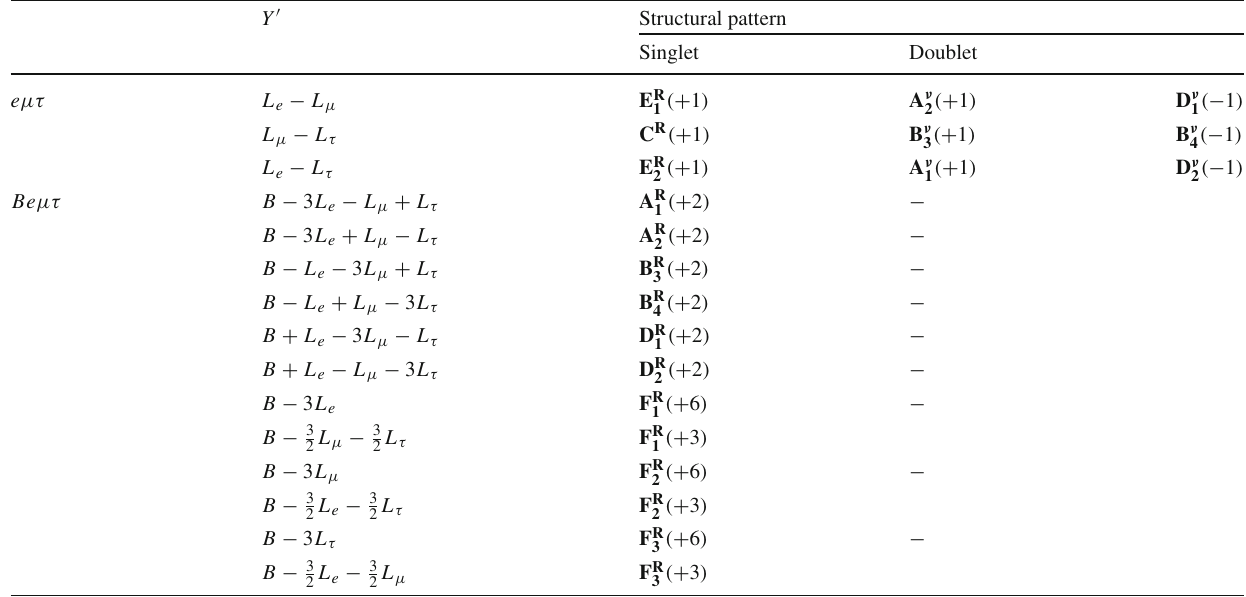
Table2 GaugedU(1)flavorsymmetrieswhichrealizetheTZMorTZT (TZT) structure of the light neutrino mass matrix. Numbers in parenthe- structures and their structural patterns. The notations for the structural ses represent the U(1) Y (cid:4) charges of the U(1) Y (cid:4) -breaking scalar singlets patterns of the TZM and TZT structures [75,76] are written in Table 3. and doublets and “ − ” means that the corresponding U(1) Y (cid:4) cannot real- The index R ( ν ) means that the corresponding symmetry realizes TZM ize the TZM or TZT structure Y (cid:4) Structural pattern Singlet Doublet